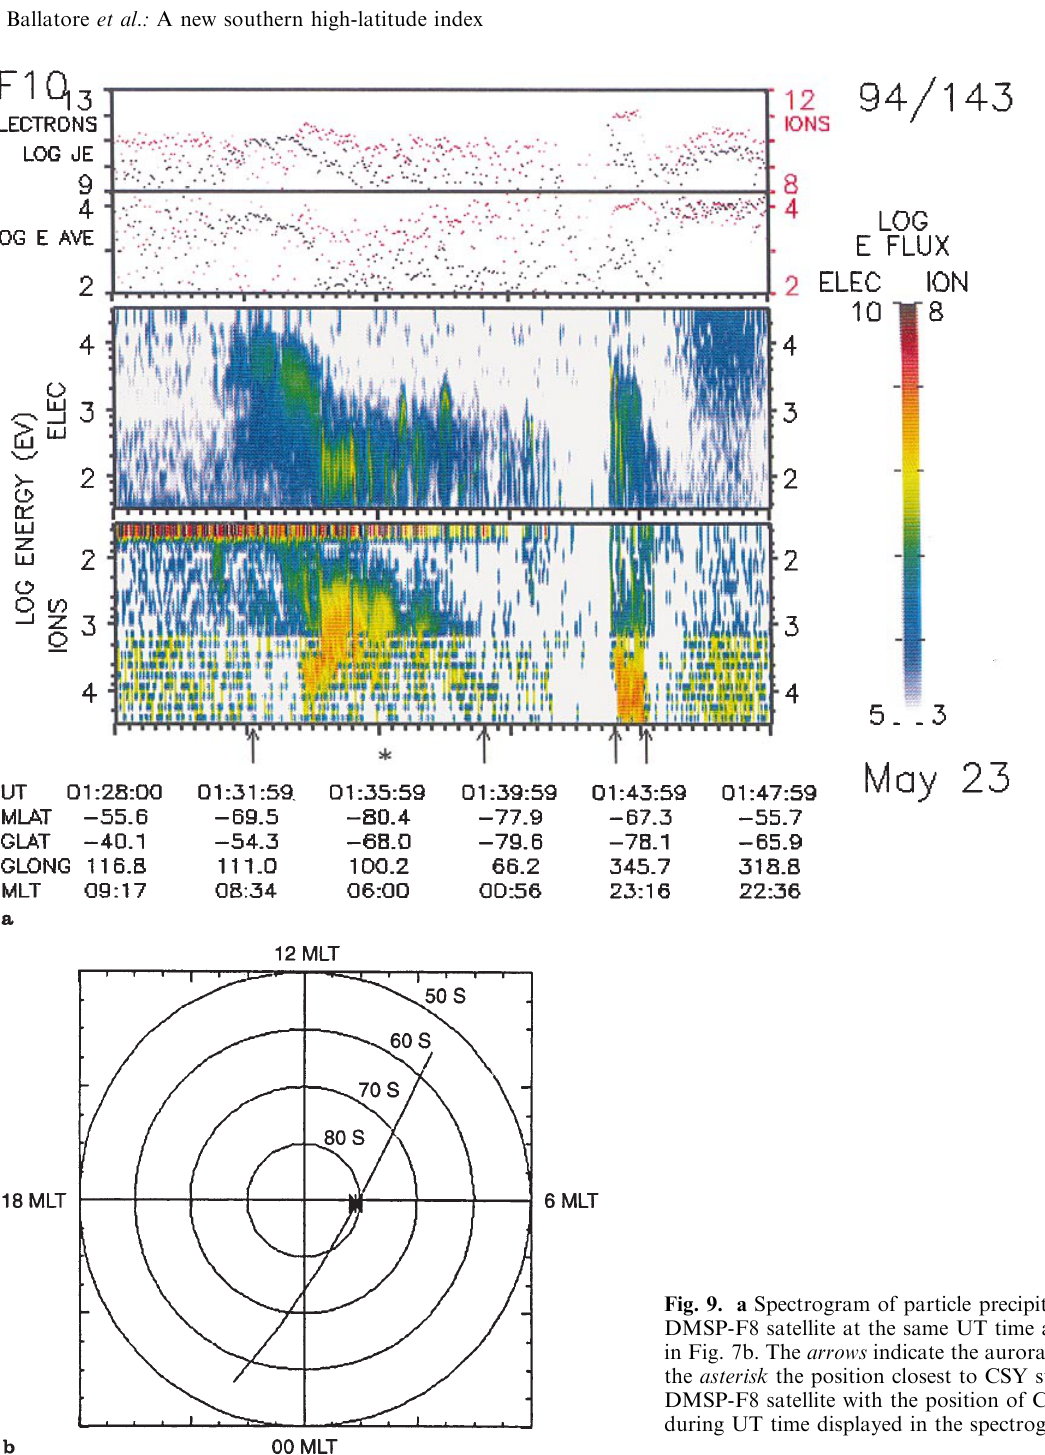
Fig. 9. a Spectrogram of particle precipitation measured by DMSP-F8 satellite at the same UT time as the event displayed in Fig. 7b. The arrows indicate the auroral oval boundaries and the asterisk the position closest to CSY station. b Pass of DMSP-F8 satellite with the position of CSY (indicated by *) during UT time displayed in